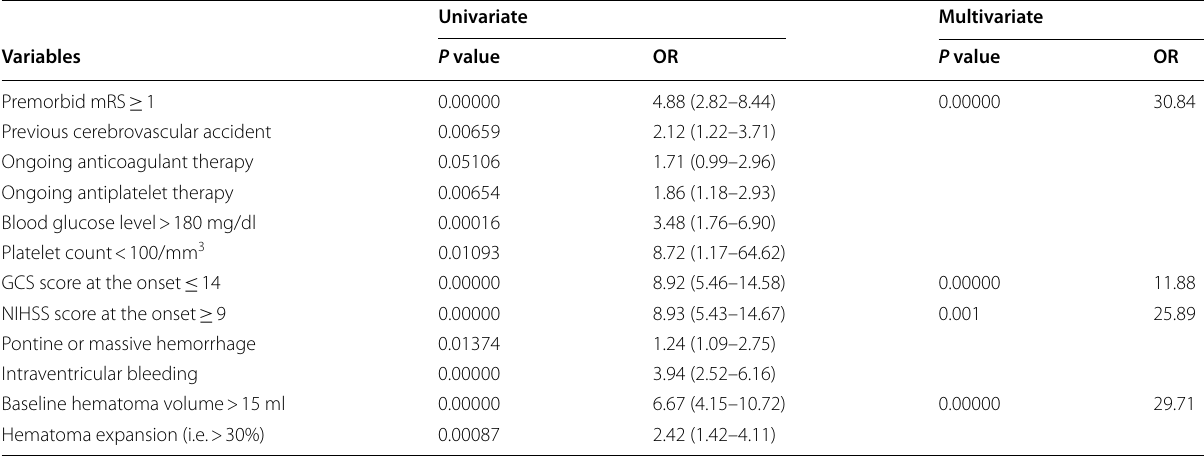
Table 3 Univariate and multivariate regression analyses for predictors of poor outcome (mRS > 2) Univariate Multivariate Variables P value OR P value